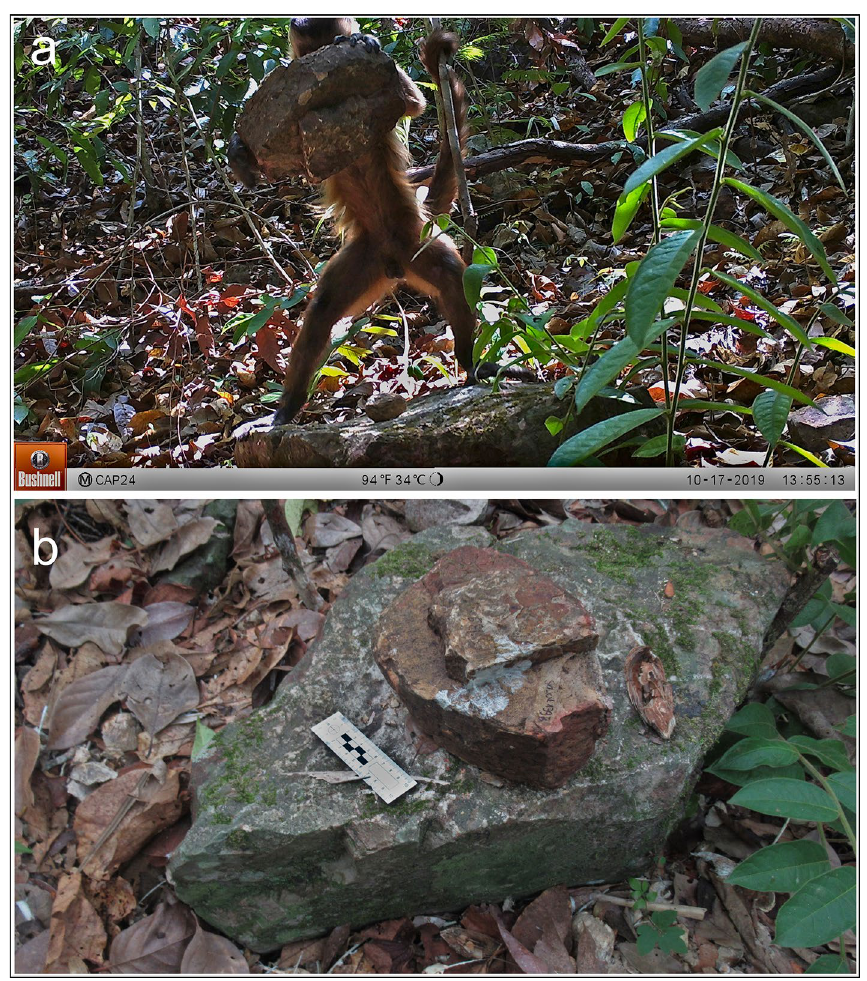
Figure 5. ( a ) Capuchin monkey from CVNP recorded on camera-trap using a 4650 g stone tool to crack open an Attalea palm nut. ( b ) The stone tool used. 10 cm